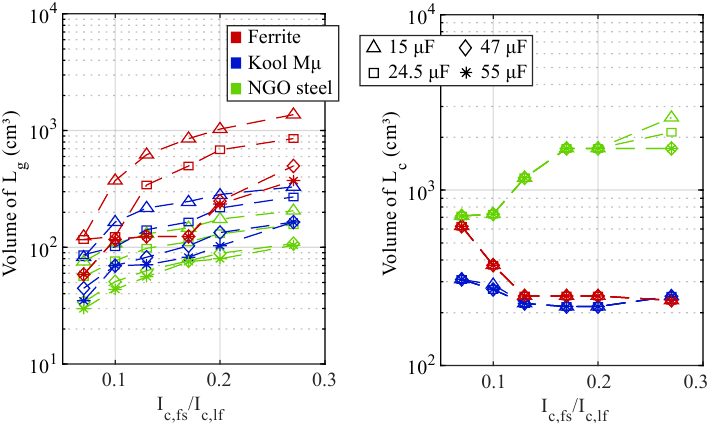
Figure 4. Inductor volumes of L c and L g with different technologies as a function of I c , f for different C f